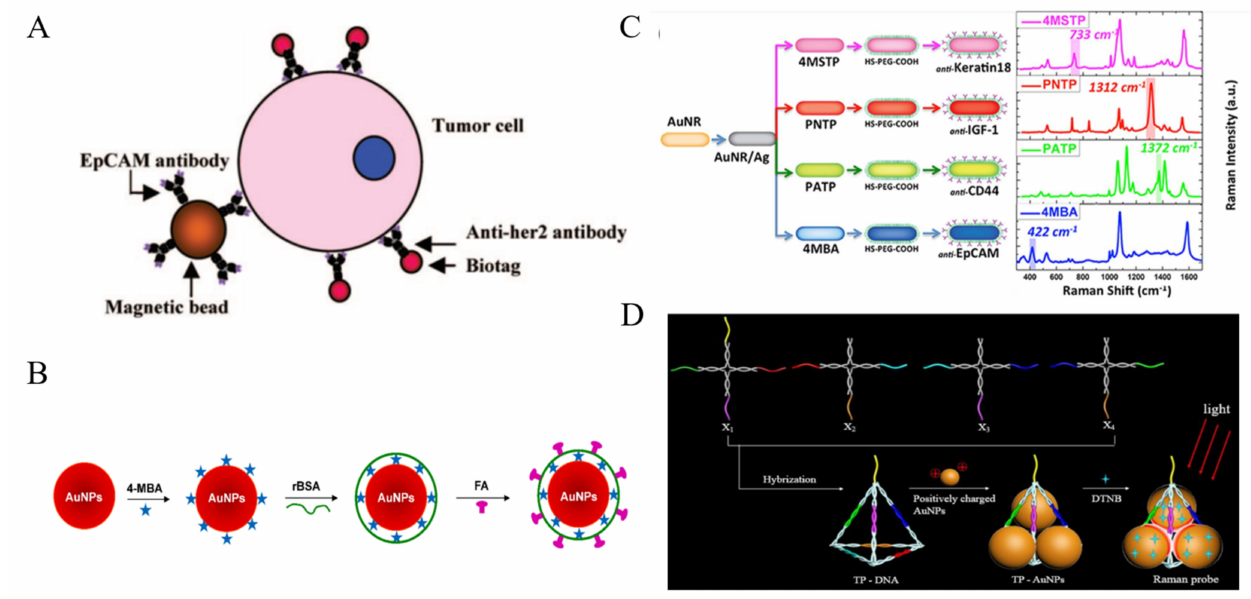
Figure 6. ( A ) Schematic representation of the ternary immuno-complex formed by nanoplexbiotags and MBs binding to the tumor cell [113]. Copyright 2008 American Chemical Society. ( B ) Schematic representation of the design of AuNPs-4- MBA-rBSA-FA SERS NPs [115]. Copyright 2015 American Chemical Society. ( C ) Schematic diagram (preparation steps) and Raman spectra (acquisition time 50 s) for the four families of SERS nano-agents [121]. Copyright 2014 Springer Nature. ( D ) Schematic representation of the synthesis of TP-AuNPs as the Raman probe [123]. Copyright 2019 American Chemical